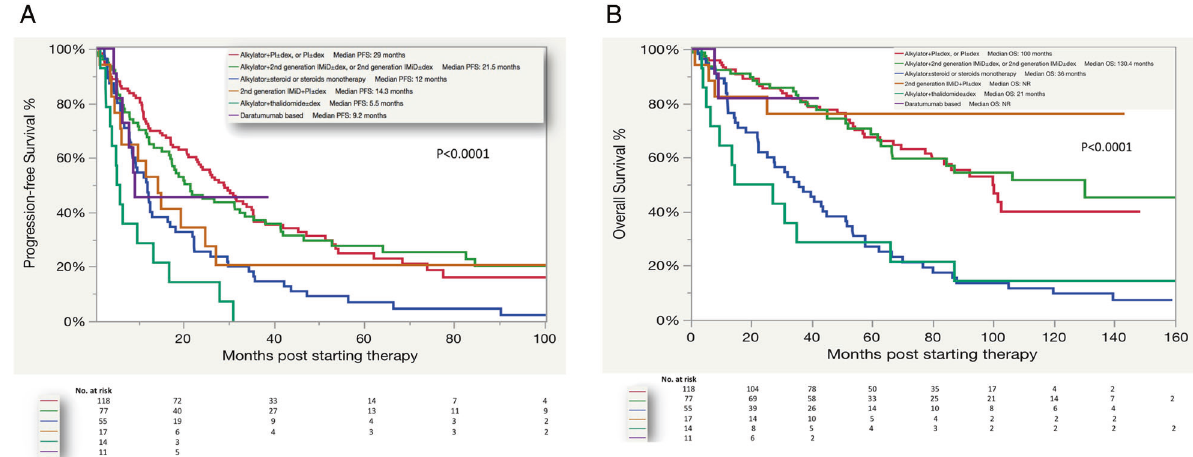
Fig. 2 Survival of the whole cohort by the different regimens. PFS ( A ) and OS ( B ). PFS progression-free survival, OS overall survival, PI proteasome inhibitor, dex dexamethasone, IMiD immunomodulatory drug, NR not